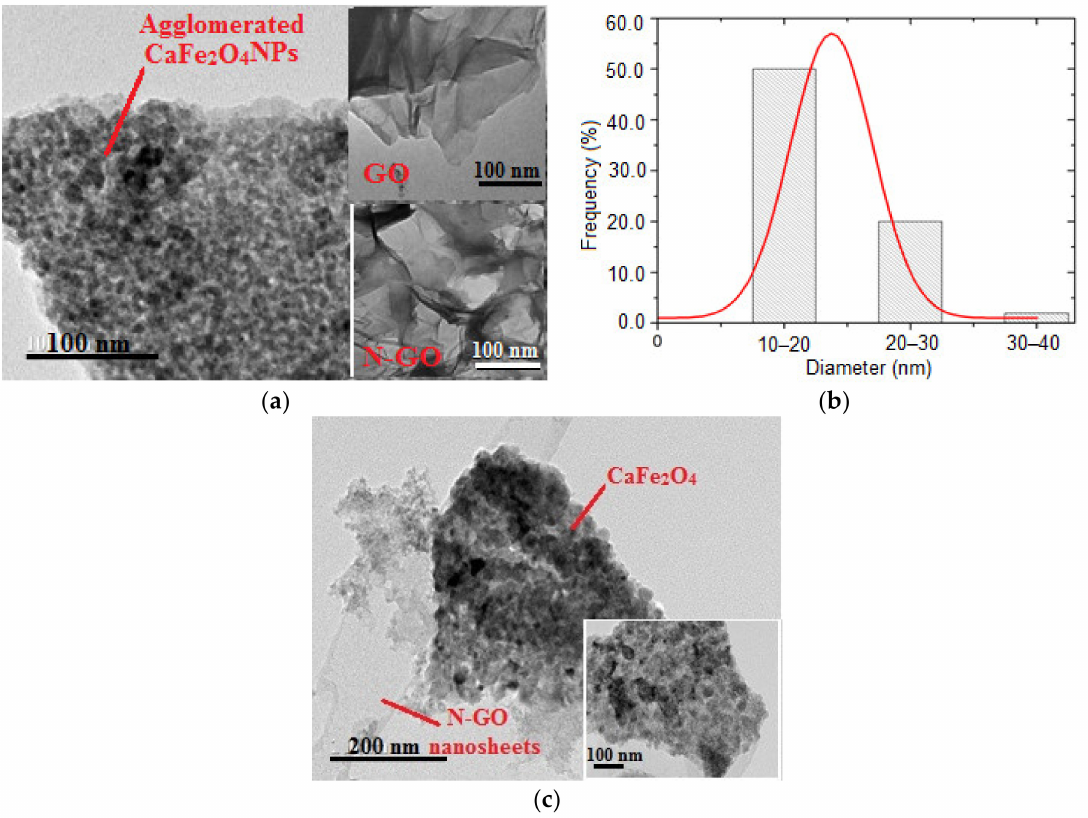
Figure 3. TEM of ( a ) CaFe 2 O 4 , GO, N-GO, ( b ) Particle size histogram of CaFe 2 O 4 and ( c ) TEM of CaFe 2 O 4